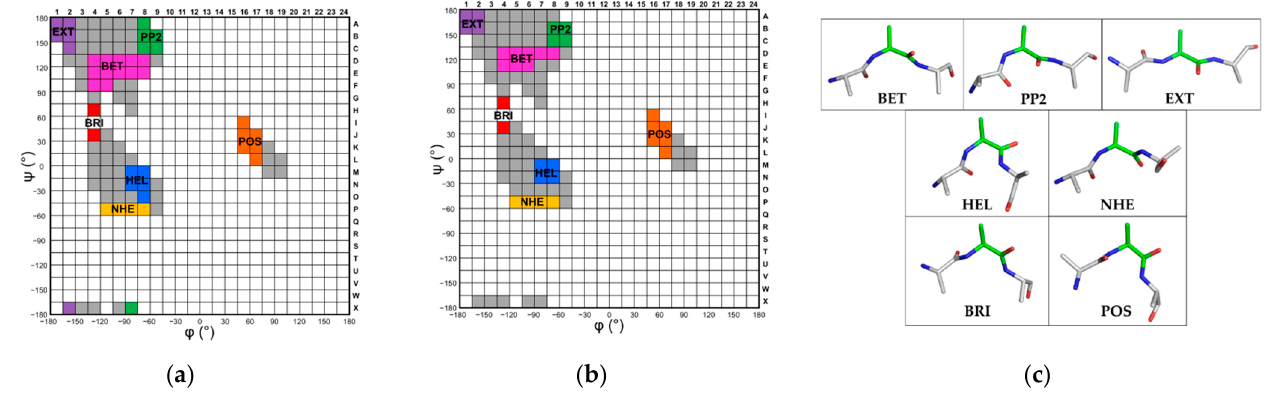
Figure 1. The 95 ( φ , ψ ) boxes (15° × 15°) containing at least 1000 residues in Data2.2 are colored. Adjacent boxes displaying similar propensity scales of ( a ) the 9AA (R > 0.8, p -value < 0.01) or ( b ) the 18AA (R > 0.6, p -value < 0.01) were clustered and depicted with the same color. Boxes whose propensity scales do not correlate with the others are in grey. The notation of the clusters is explained in the main text. ( c ) Stick representation of an alanine tripeptide with the central residue adopting ( φ , ψ ) dihedral angles corresponding approximately to the center of the different clusters identified in the Ramachandran plot: BET ( − 105°, 120°), PP2 ( − 60°, 150°), EXT ( − 165°, 165°), HEL ( − 75°, − 15°), NHE ( − 90°, − 67.5°), BRI ( − 127.5°, 60°), and POS (60°, 30°).